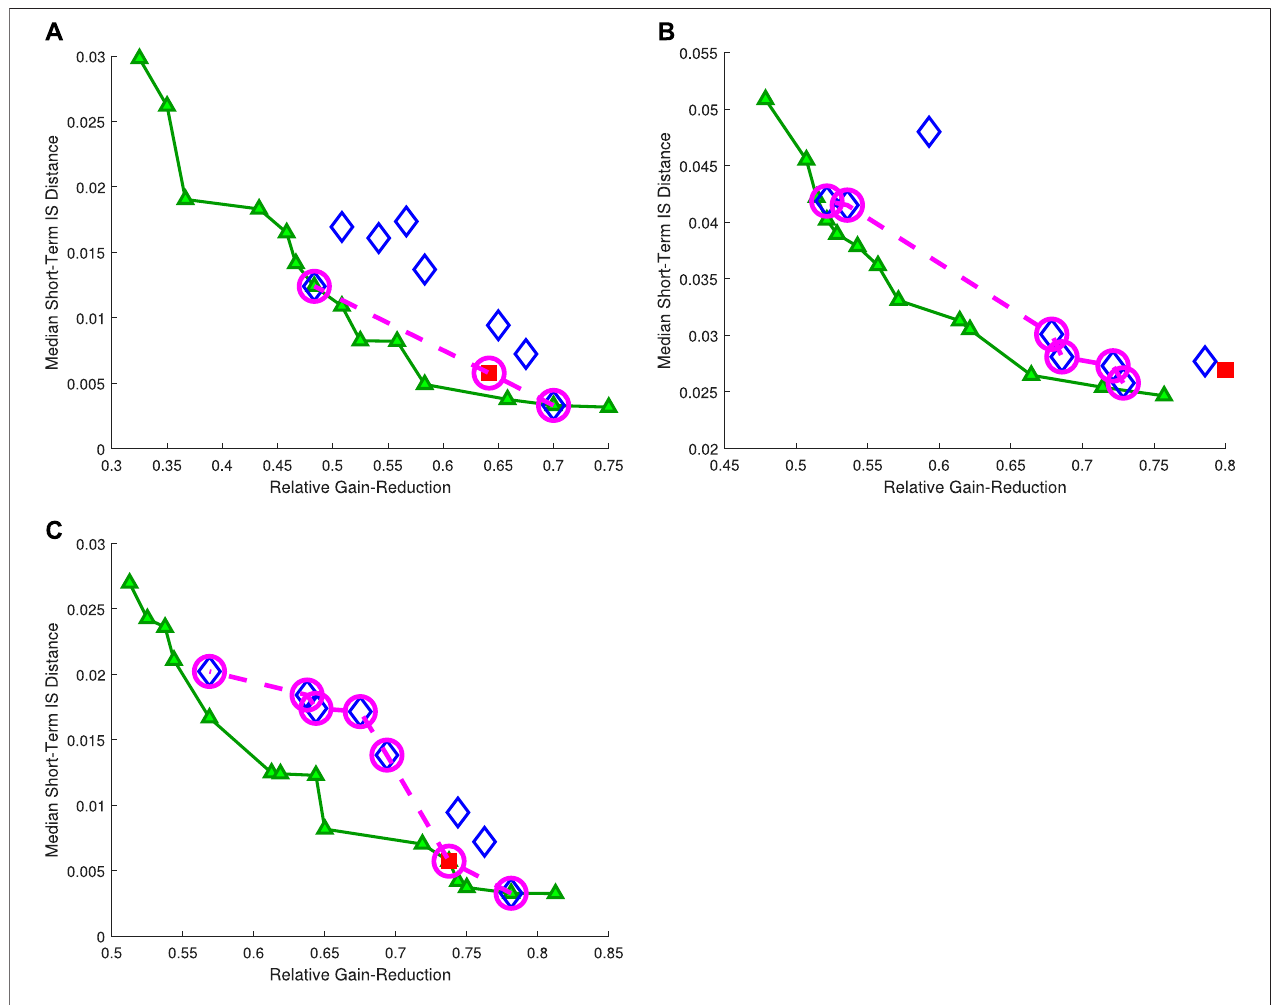
FIGURE8 | Performance vectors ofthe Pareto-frontmic2-locations (connected green triangles), worst-case Pareto-front mic2-locations(blue diamonds),and the single-microphone solution(red square). Thedashed-line connected magenta circles denote thePareto frontthat considers theworst-casePareto-frontmic2-locations and the single-microphone solution. The graphs are extracted under the scenarios: (A) K = 6 and clean-signal; (B) K = 7 and noisy-signal; (C) K = 8 and clean-signal.